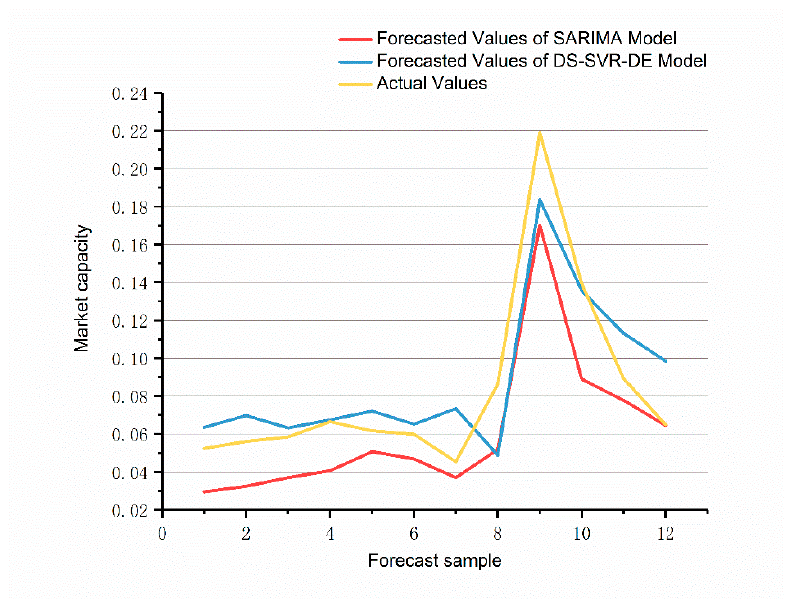
Figure 6. The long-term prediction performance of the proposed DS-SVR model and the SARIMA model in the medium-sized type.